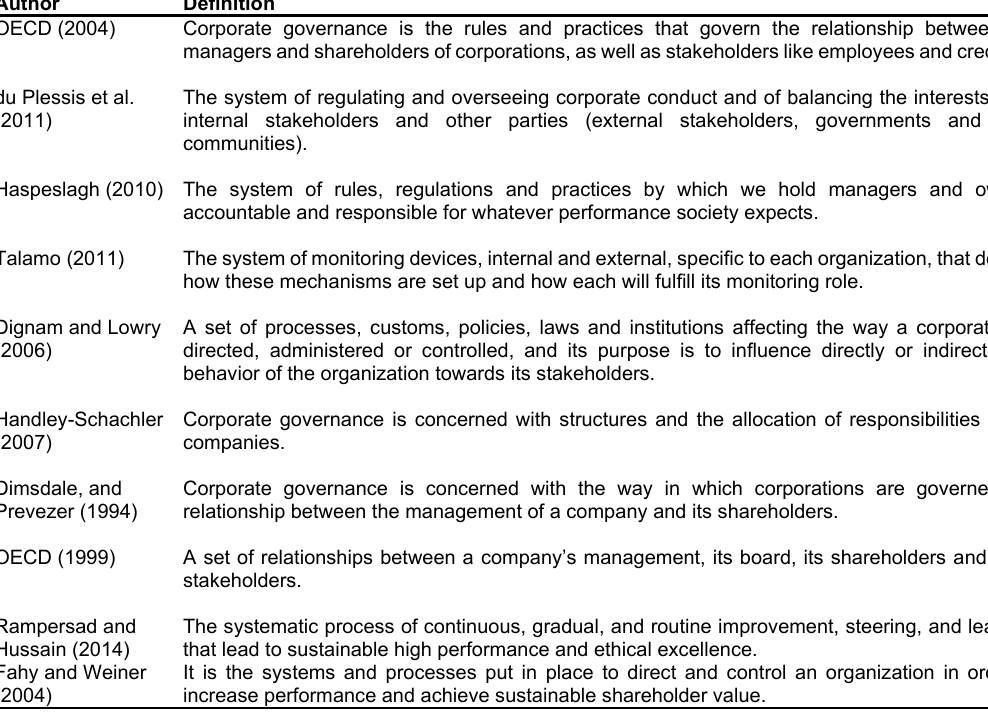
Table 1. Corporate governance